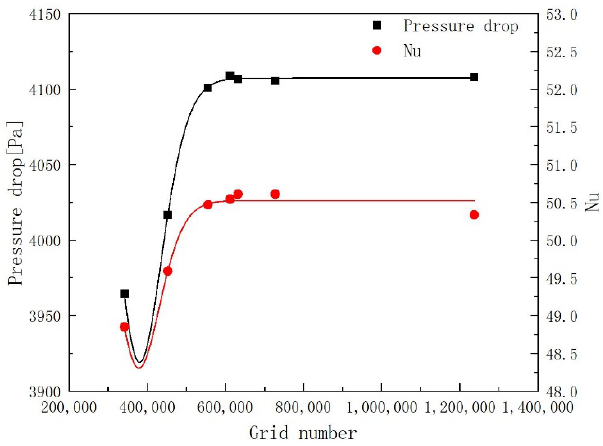
Figure 5. Grid independence analysis.